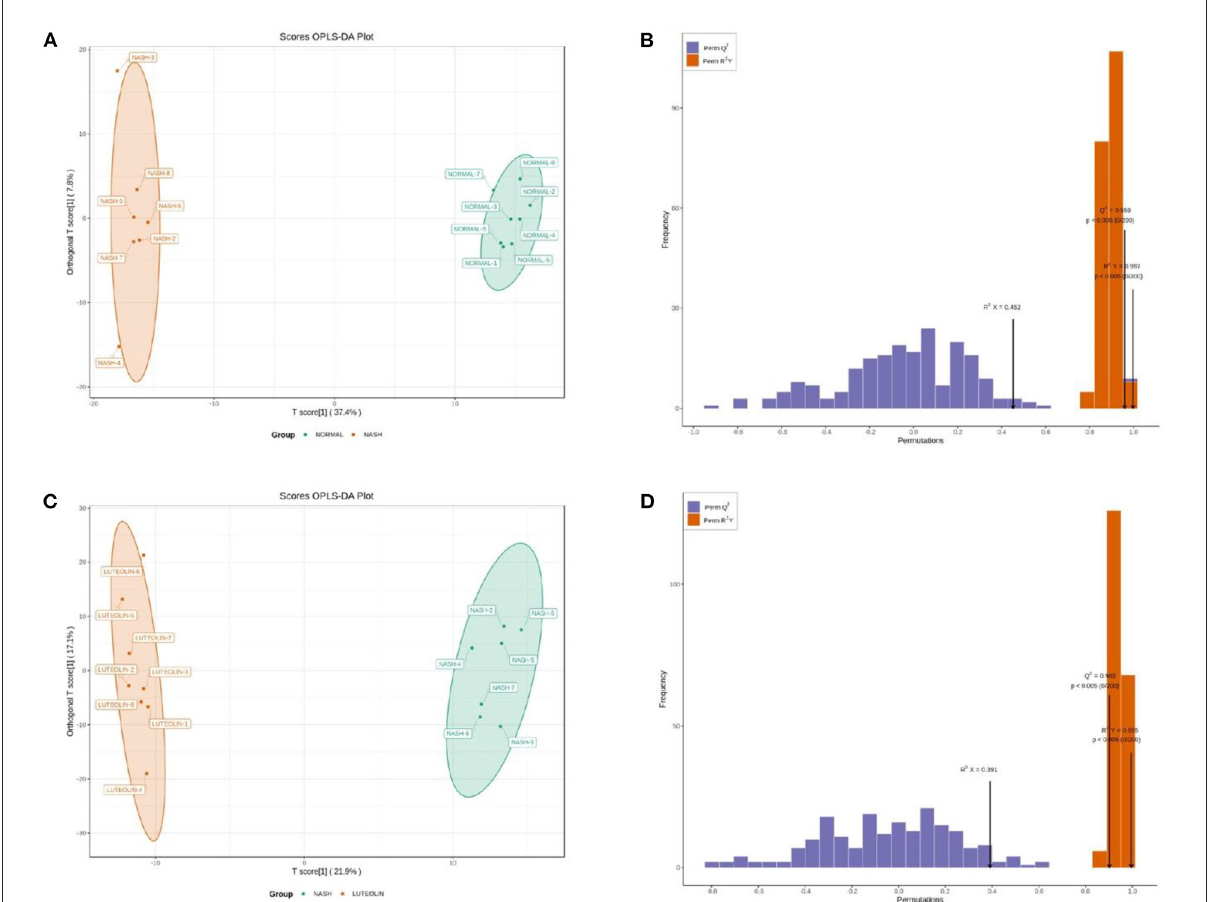
FIGURE2 (A) OPLAS-DA scoring map between Normal and NASH groups; (B) model validation of OPLAS-DA scoring map between Normal and NASH groups; (C) OPLAS-DA scoring map between NASH and Luteolin groups; (D) model validation of OPLAS-DA scoring map between NASH and Luteolin